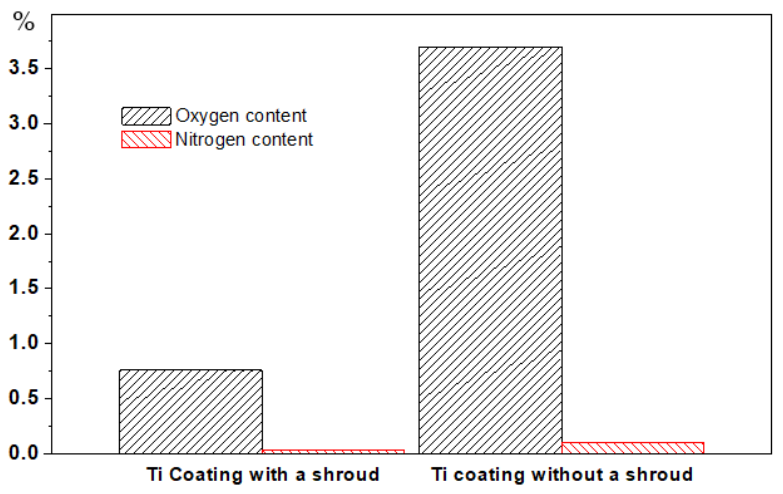
Figure 5. The contents of nitrogen and oxygen in the plasma-sprayed titanium coatings with and without the shroud.